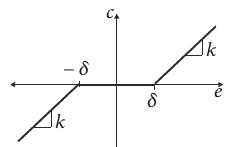
Figure 3: Representation of a dead-zone nonlinearity.